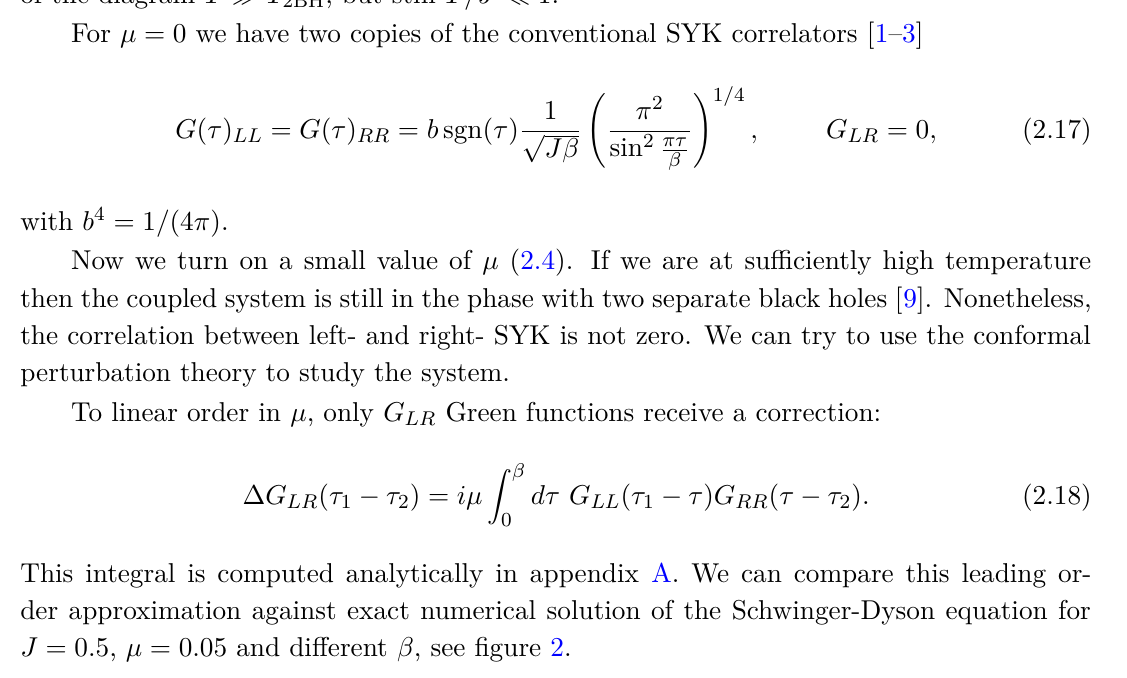
61 . The approximation 2BH ∼